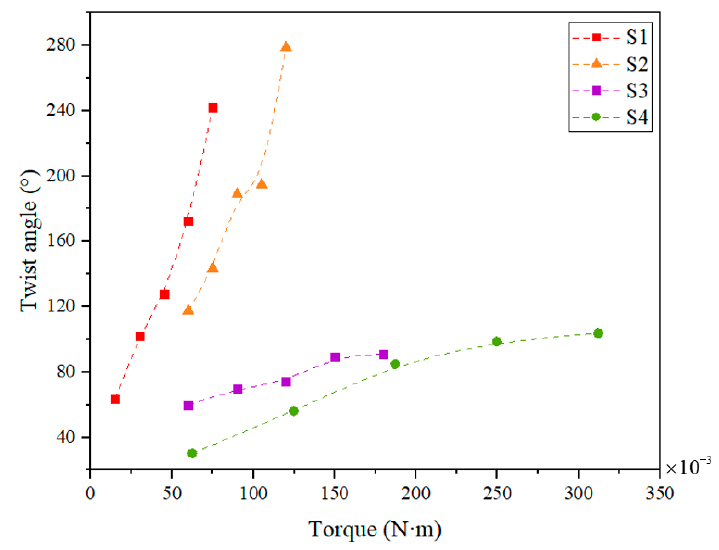
Figure 13. Summary of the twist angle as a function of the applied torque.